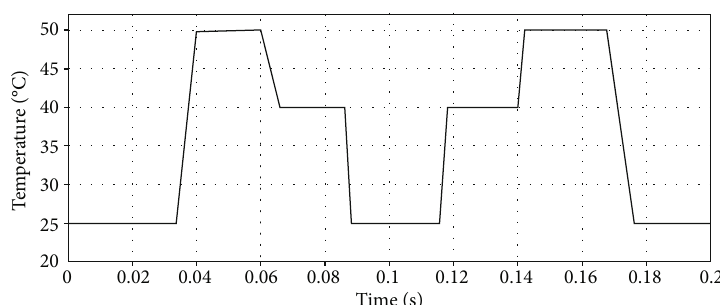
Figure 15: Scenario of temperature variation.